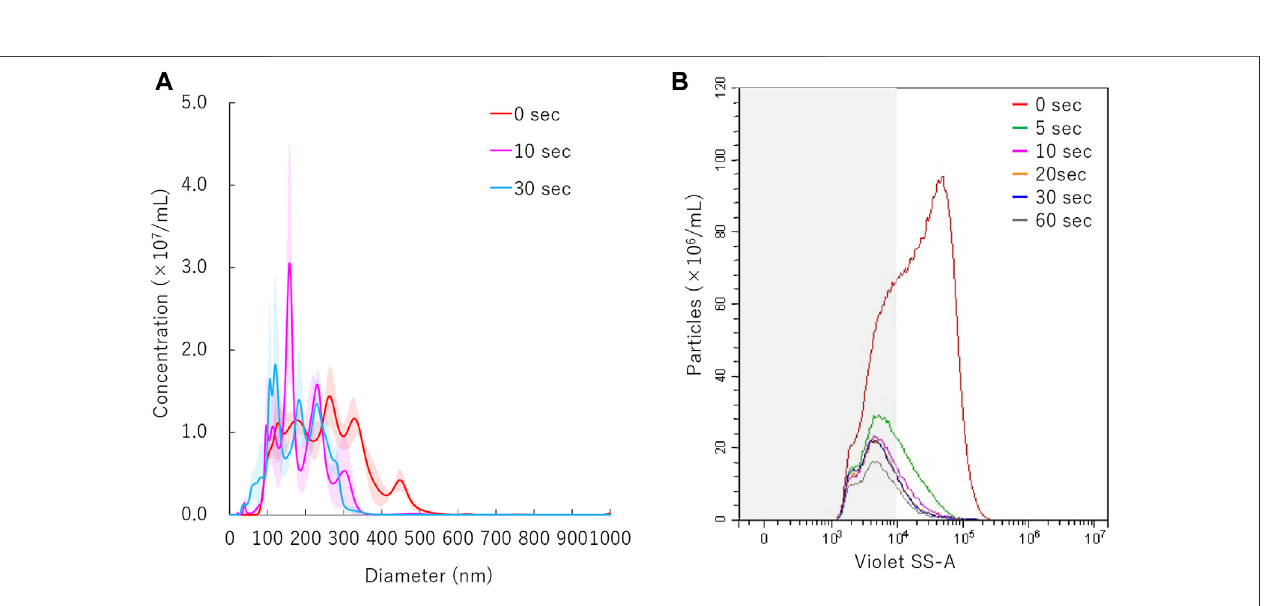
Frontiers in Pharmacology |